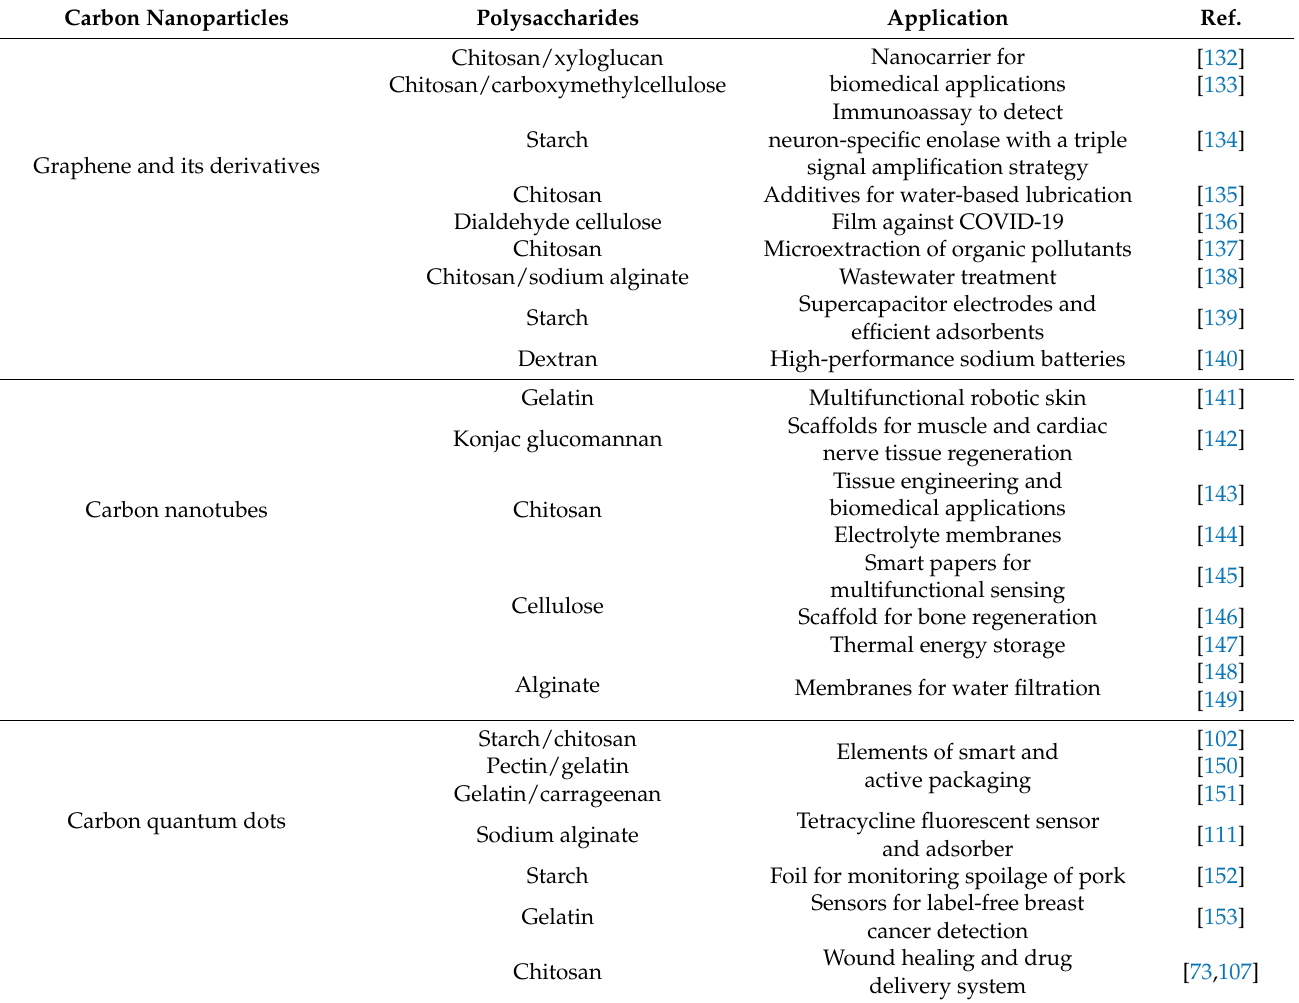
Table 1. Selected applications of polysaccharides as carbon-based nanoparticles